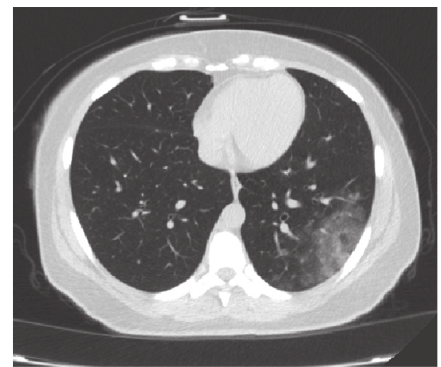
Figure 8: Halo sign in a case of PCR proved